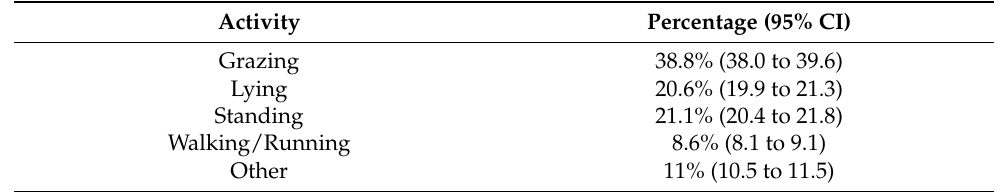
Table 2. Activity budget percentage (95% confidence interval) of overall epochs (5 s periods) that were classified as grazing, lying, standing, walking/running or other from filmed ewe